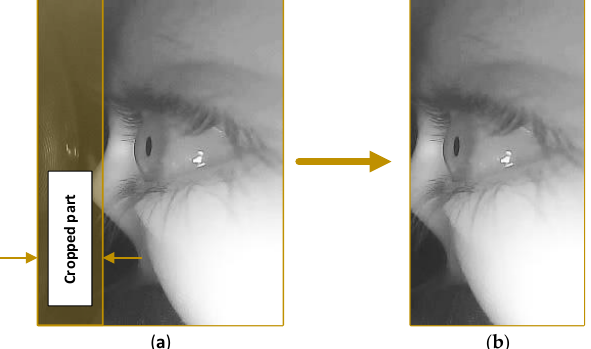
Figure 5. The captured frame: ( a ) Captured frame before the crop, with frame resolution 240 × 320 pixels; ( b ) Captured frame after the crop, with frame resolution 170 × 320 pixels.